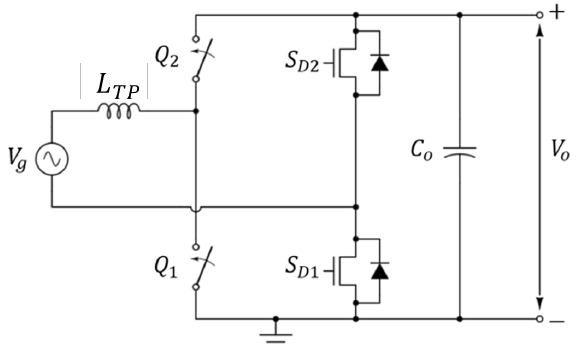
Figure 2. Totem Pole bridge-less PFC boost converter with MOSFETs for line